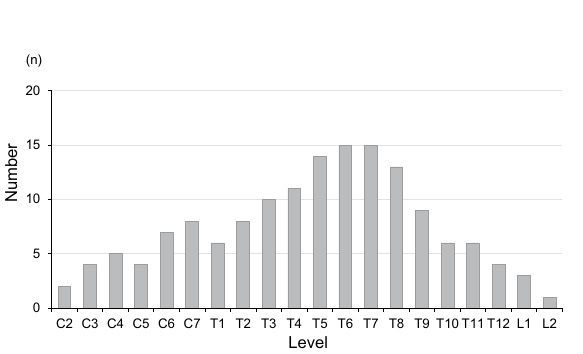
Figure 2. Sagittal tumor location in 116 spinal meningioma (with overlap in some